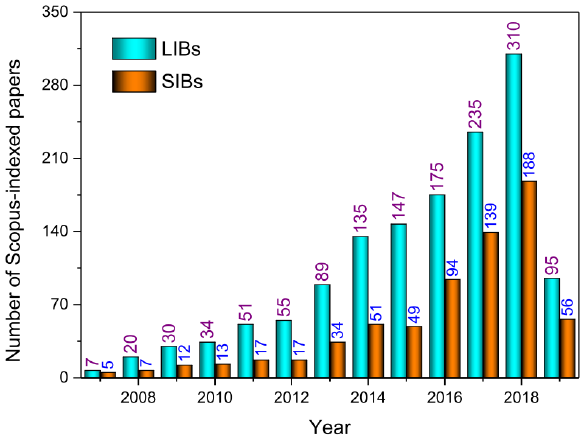
Figure 6. Time distribution of papers dealing with lithium- and sodium-ion batteries (LIBs and SIBs) based on ENMs published in Scopus-indexed scientific journals from 2007 to January 2019.